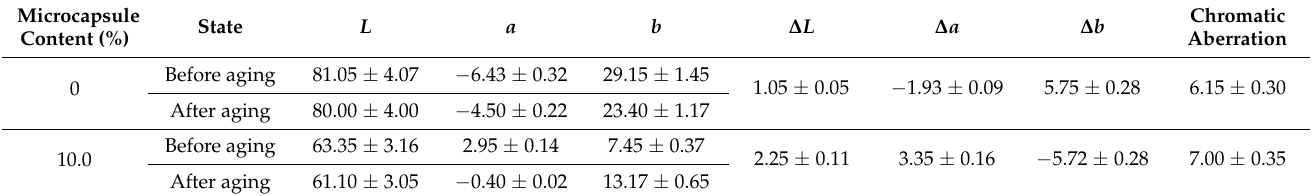
Table 14. Color-difference change after aging test of coating with 0 and 10% microcapsule addition.